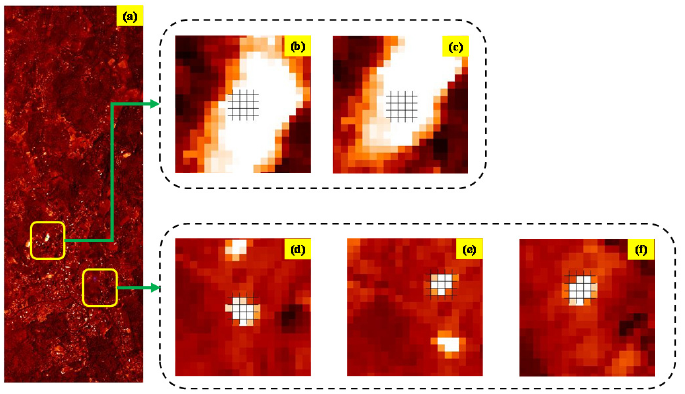
Figure 14. Target detection score image from ( a ) airborne imagery using airborne target reference spectrum and the enlarged detection score footprint for ( b ) N3Y, ( c ) N4B, ( d ) N1G, ( e ) N2R, and ( f ) C1W target.